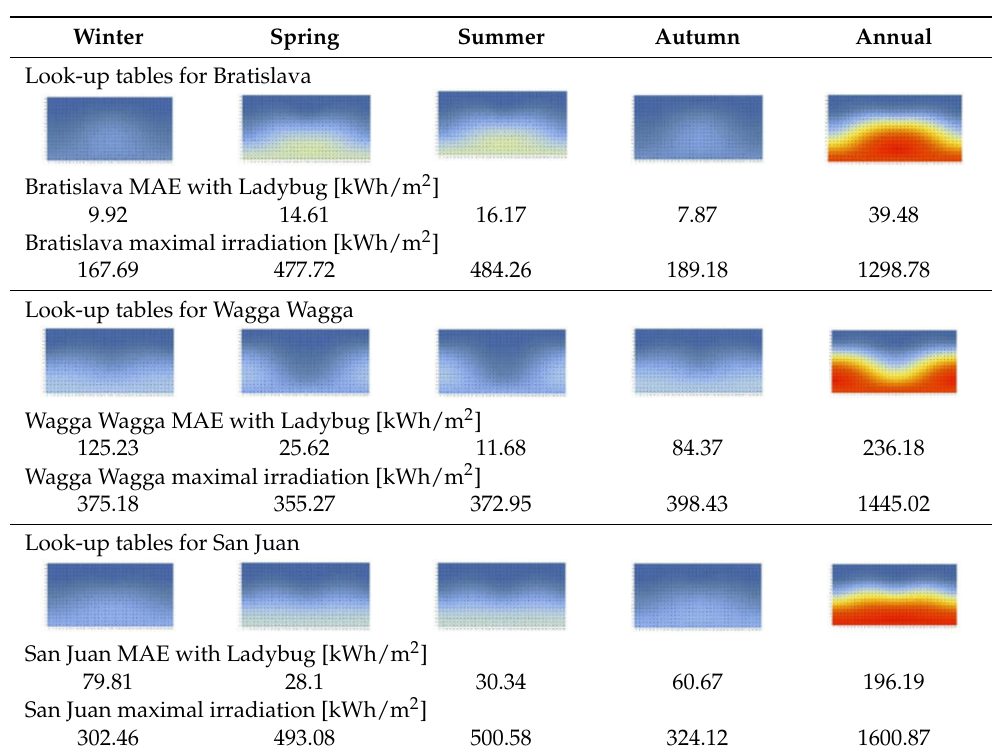
Table 1. Generated look-up tables for annual and seasonal solar potential calculated with Mikler and Kittler’s model and their MAE with the Ladybug model. The images within the table provide a visual overview of the calculated values; a file with readable values for each field of the look-up tables can be found online at: https://doi.org/10.6084/m9.figshare.21768332.v1 (accessed on 22 December